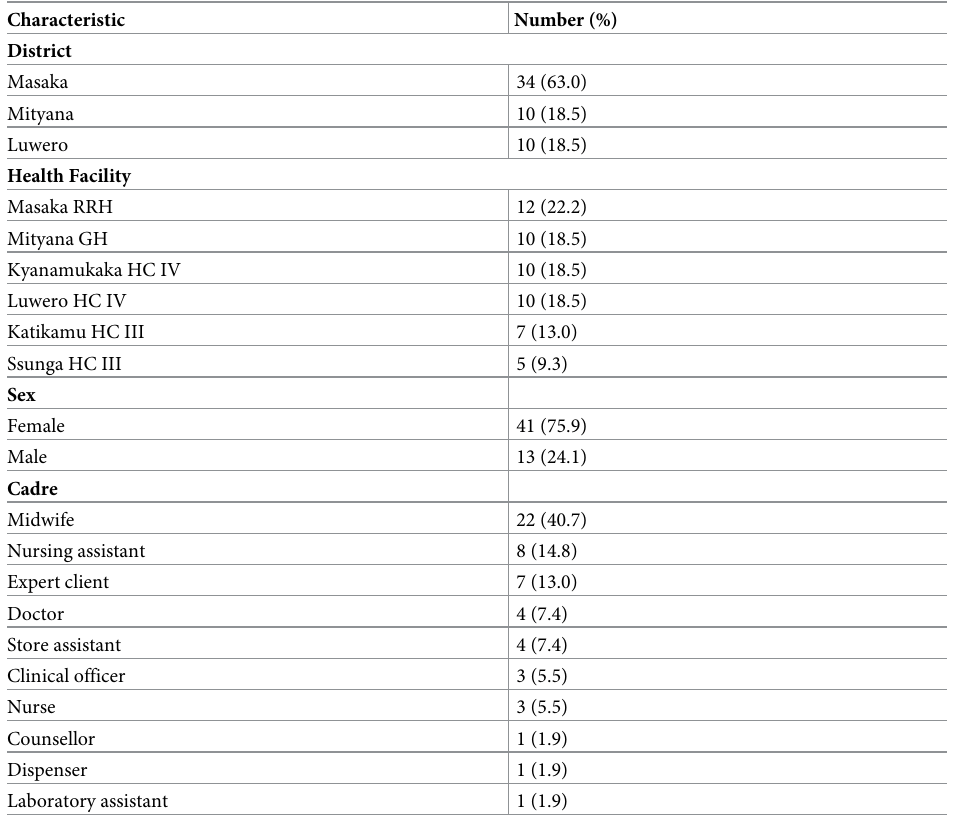
Table 2. Characteristics of study participants (n =